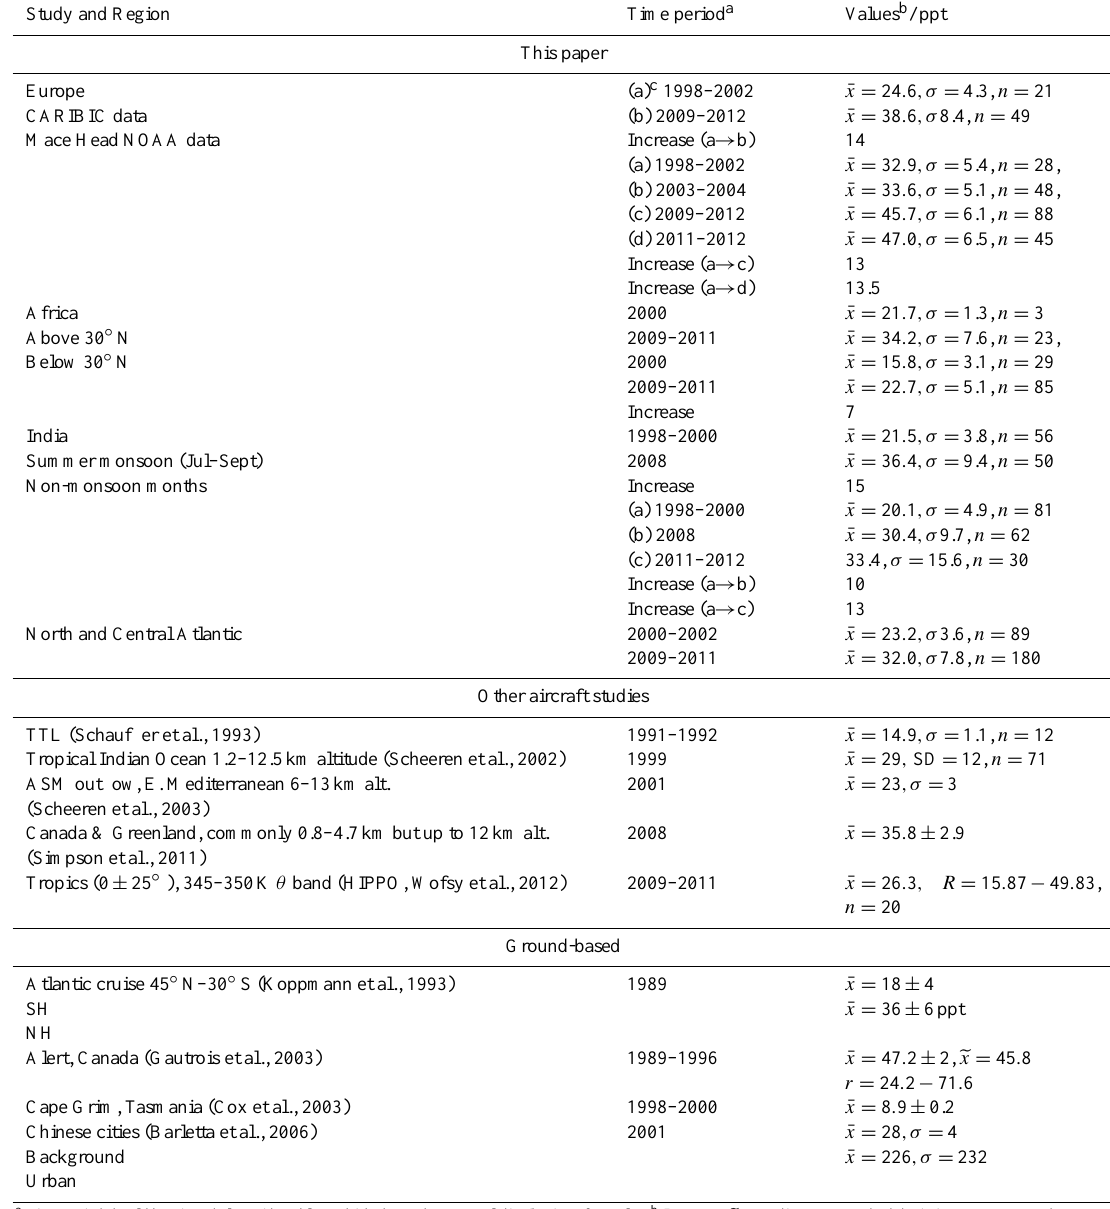
Table 2. CH 2 Cl 2 descriptive statistics for regions included in this study and a comparison to data from the existing literature. Study and